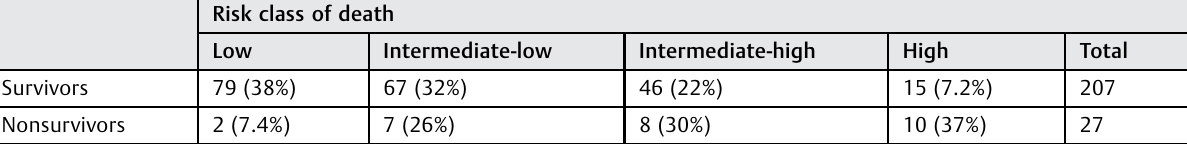
Table 3 Risk class of early death (within 30 d after acute PE) calculated at PE